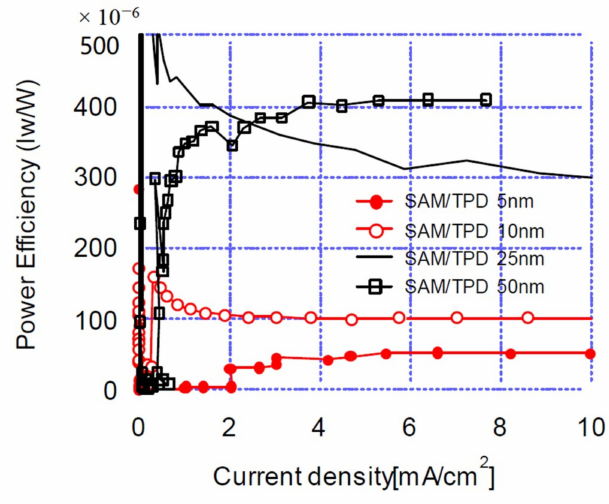
Figure 6. Power efficiency-current density characteristics of OLED devices at 5, 10, 25, 50 nm TPD